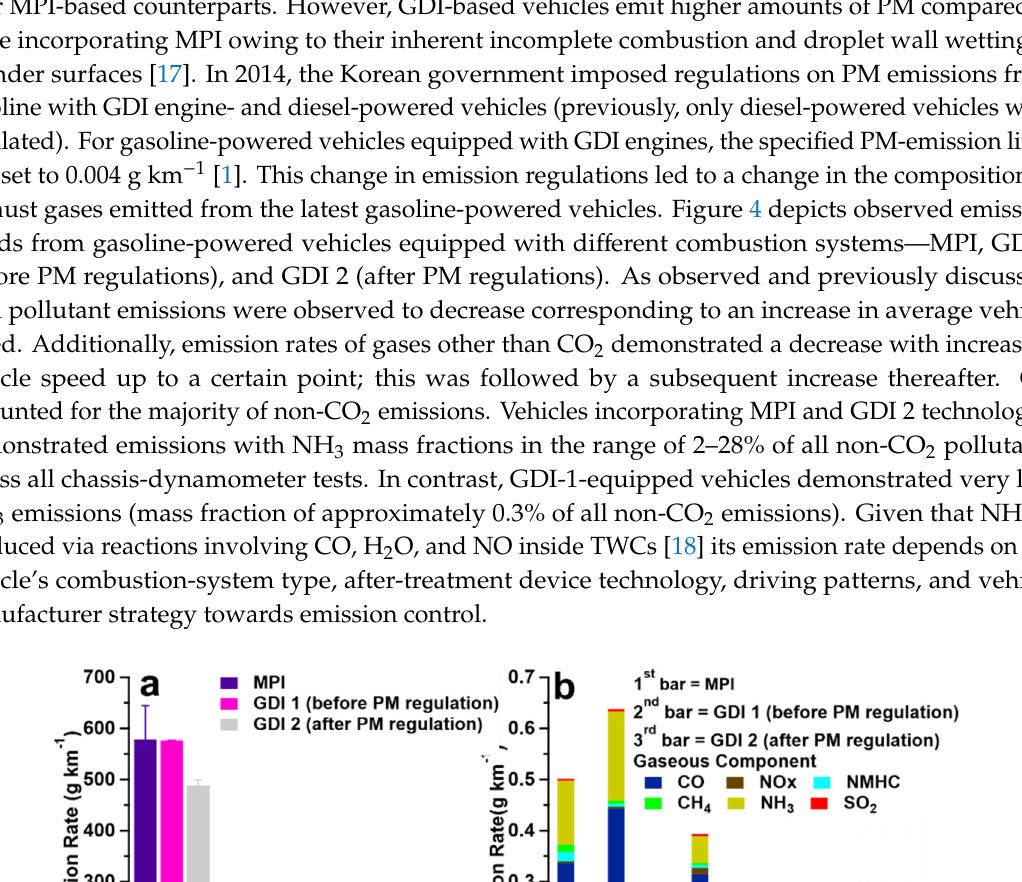
Figure 5. Observed trends in the variation of NO 2 /NOx ratio and standard deviation concerning emissions from diesel vehicles as per different emission-regulation standards for different diesel- vehicle speeds.